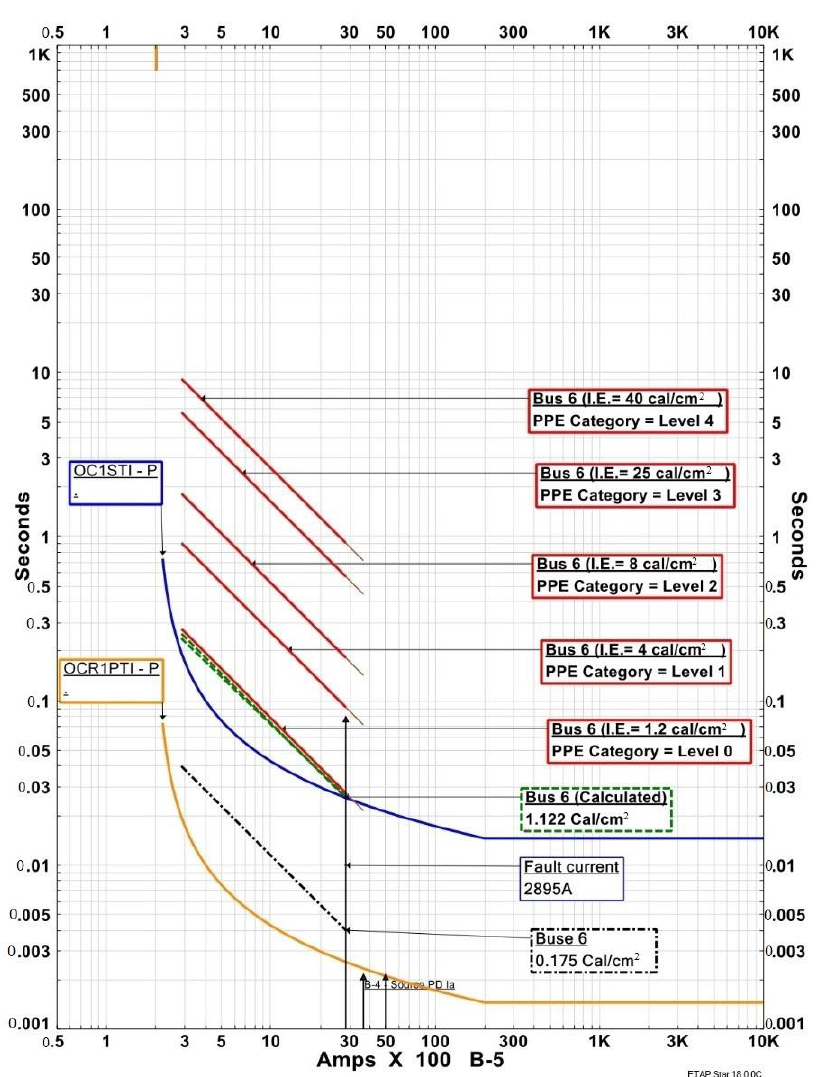
Figure 8. The industrial software analysis (ETAP) for R1 during under Mode 1 operation scenario.